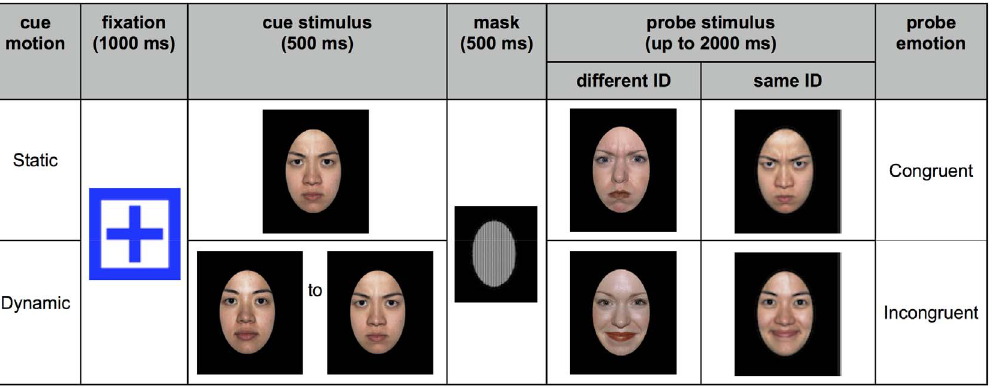
Figure 1. Experimental trial structure and stimulus examples. The faces, displayed in this figure were obtained from the NimStim facial stimulus set [40]. Consent to use these specific images was granted for publication purposes by the NimStim stimulus set developers (http://www. macbrain.org/resources.htm).